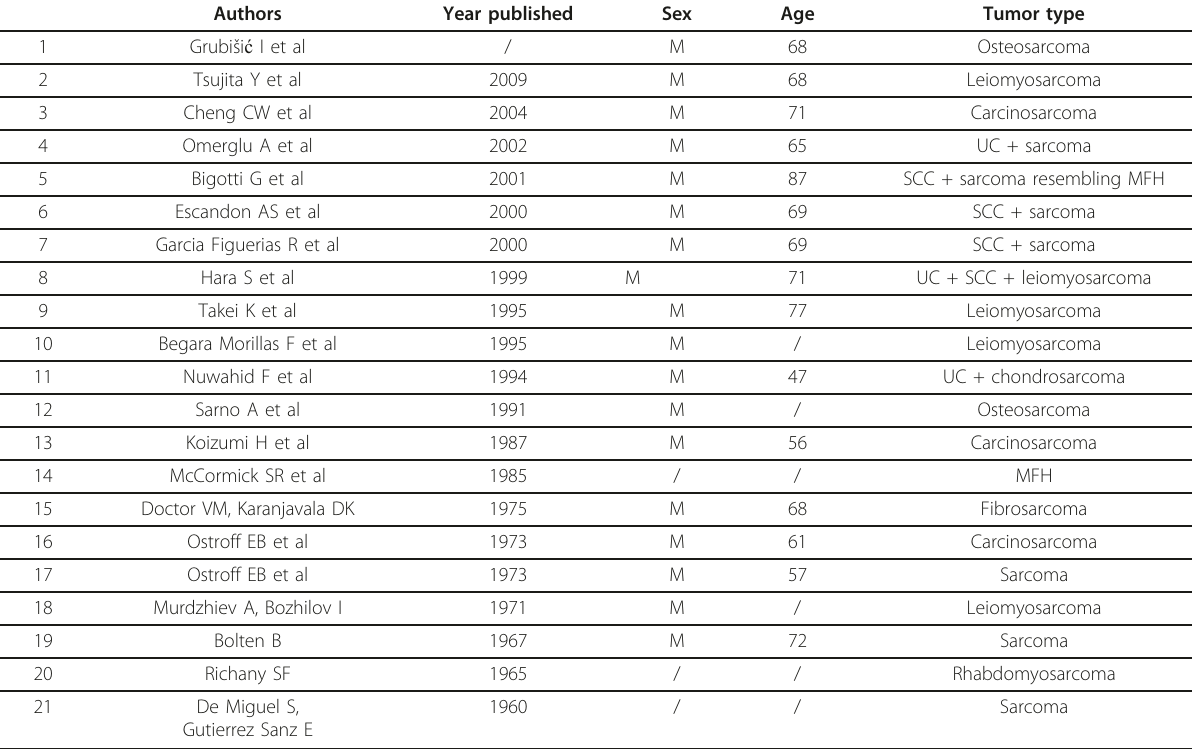
Table 1 Cases of intradiverticular sarcomas with or without carcinomatous component reported in the literature